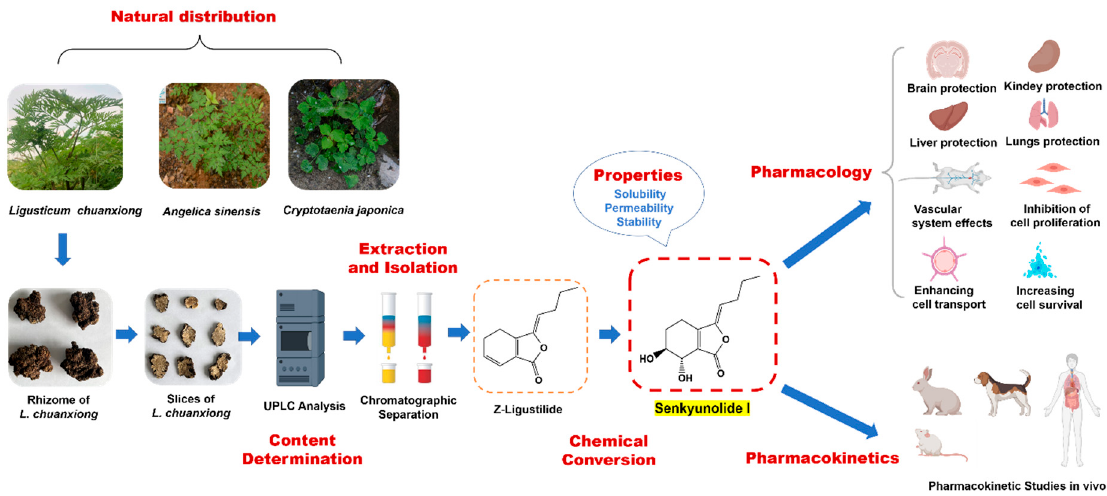
Figure 1. Chemical structure of ( a ) ligustilide and ( b ) senkyunolide I.